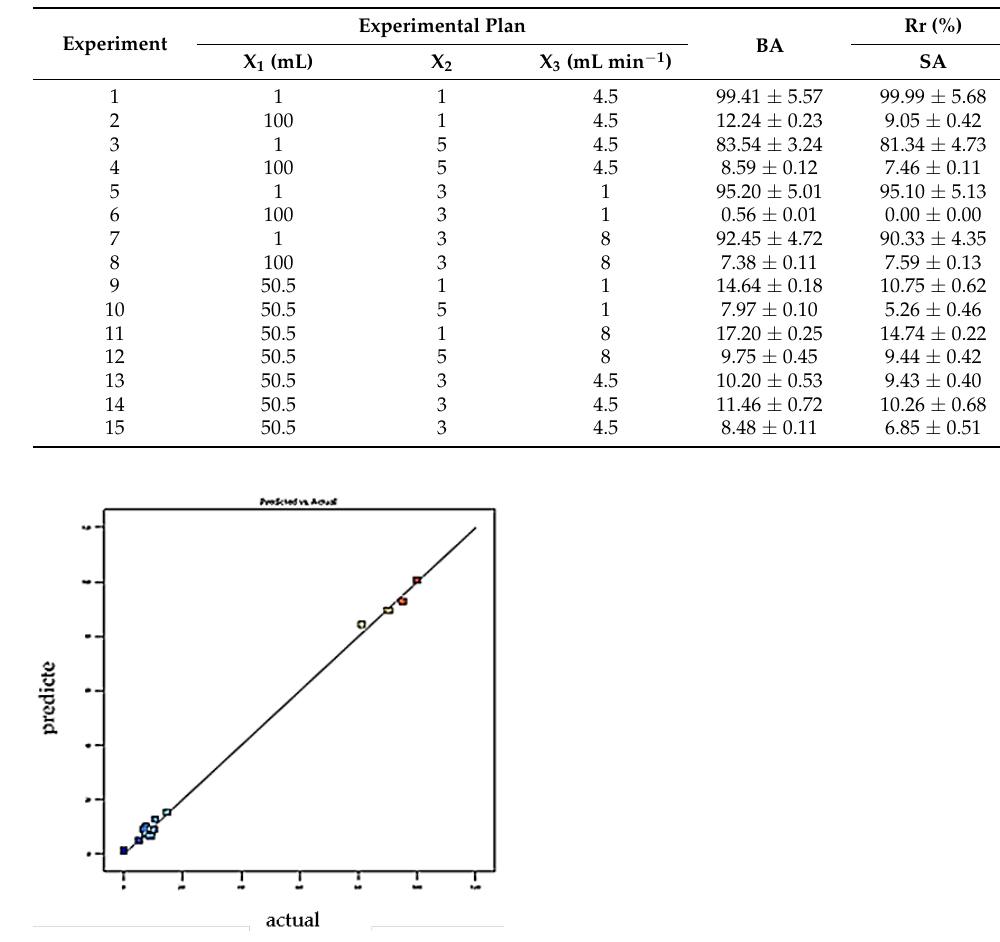
Figure 1. Plot of predicted value vs. actual value for SA retention efficiencies. Y Predicted ; p < 0.0026; R 2 adjusted = 0.98; R 2 predicted = 0.92.